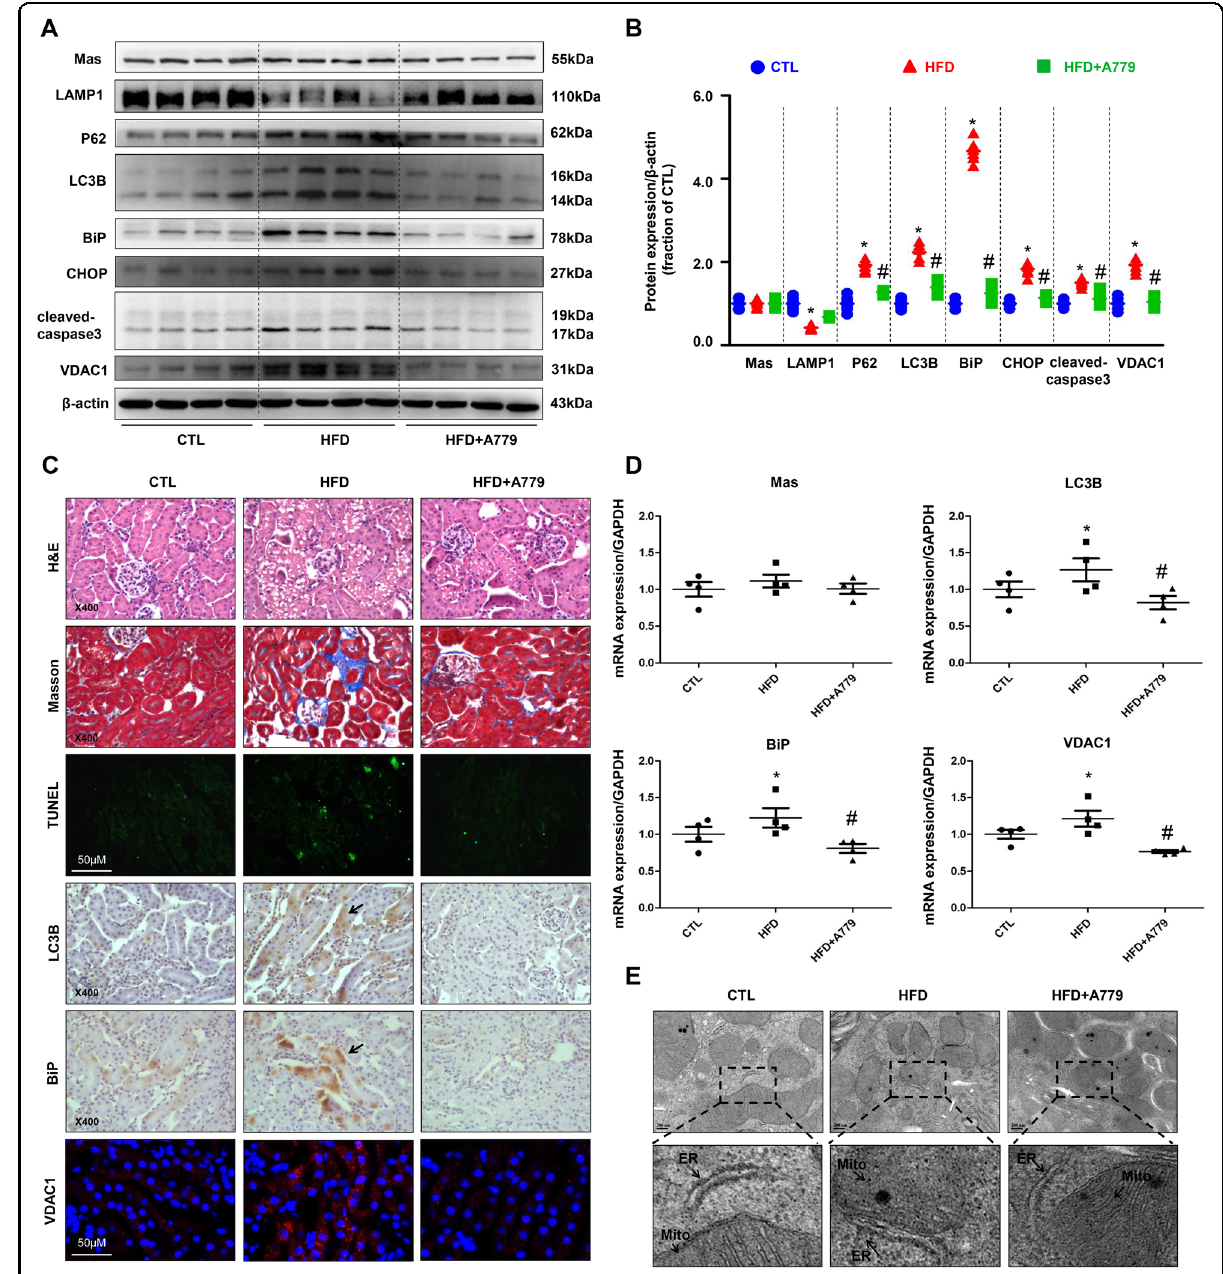
Fig. 2 Mas antagonist A779 prevented high-fat diet-induced autophagy, ER stress, and apoptosis in the cortex of kidneys in mice. A and B Representative immunoblots and corresponding densitometry analysis of Mas, LAMP1, P62, LC3B, BiP, CHOP, cleaved-caspase-3 and VDAC1 protein abundance in the kidney cortex of CTL, HFD, and HFD + A779 mice. C Representative photomicrographs of H&E, Masson staining and TUNEL staining the kidney of CTL, HFD, and HFD + A779 mice. Immunohistochemistry and immuno fl uorescence of LC3B, BiP, and VDAC1 in the kidney of CTL, HFD, and HFD + A779 mice. D mRNA levels of Mas, LC3B, BiP and VDAC1 in the kidney cortex of CTL, HFD, and HFD + A779 mice. E Representative images of mitochondria and endoplasmic reticulum by transmission electron microscopy (TEM) in proximal tubular cells prepared from HFD mice with or without A779 treatment. CTL, controls; HFD, high-fat diet; HFD + A779, high-fat diet plus A779 treatment. Data are shown as mean ± SEM; * P < 0.05 compared with CTL; # P < 0.05 compared with